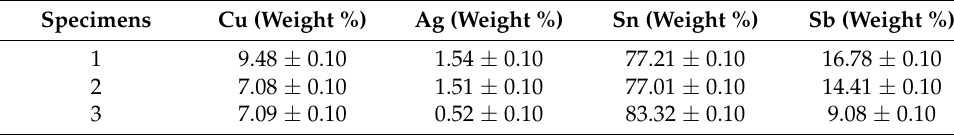
Table 3. The elemental composition of the running-in coating